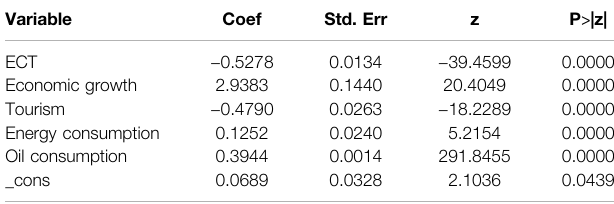
TABLE 4 | Panel cointegration.